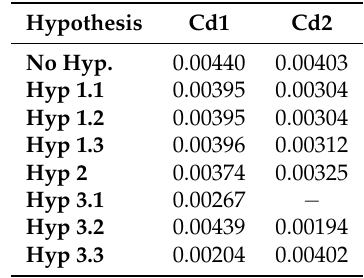
Table 12. Goodness of fit from Equation (5) of each hypothesis applied to the datasets of groups Cd1 and Cd2 at PND60.